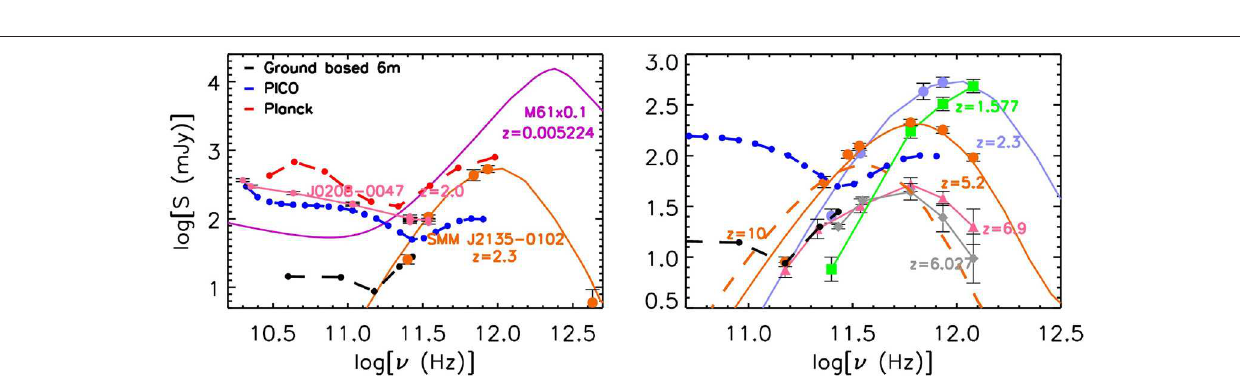
FIGURE 1 | Effect of angular resolution on the confusion limit. The filled blue circles show the differential counts of sources on SPT maps degraded to the PICO resolution at 150GHz (FWHM = 6.2 ′ ; left panel) and 220GHz (FWHM = 3.6 ′ ; right panel) compared with the SPT counts of Mocanu et al. (2013, orange stars). The vertical dot-dashed lines correspond, from left to right, to the 90% completeness limits at the full SPT resolution, at the PICO resolution and at the Planck resolution.